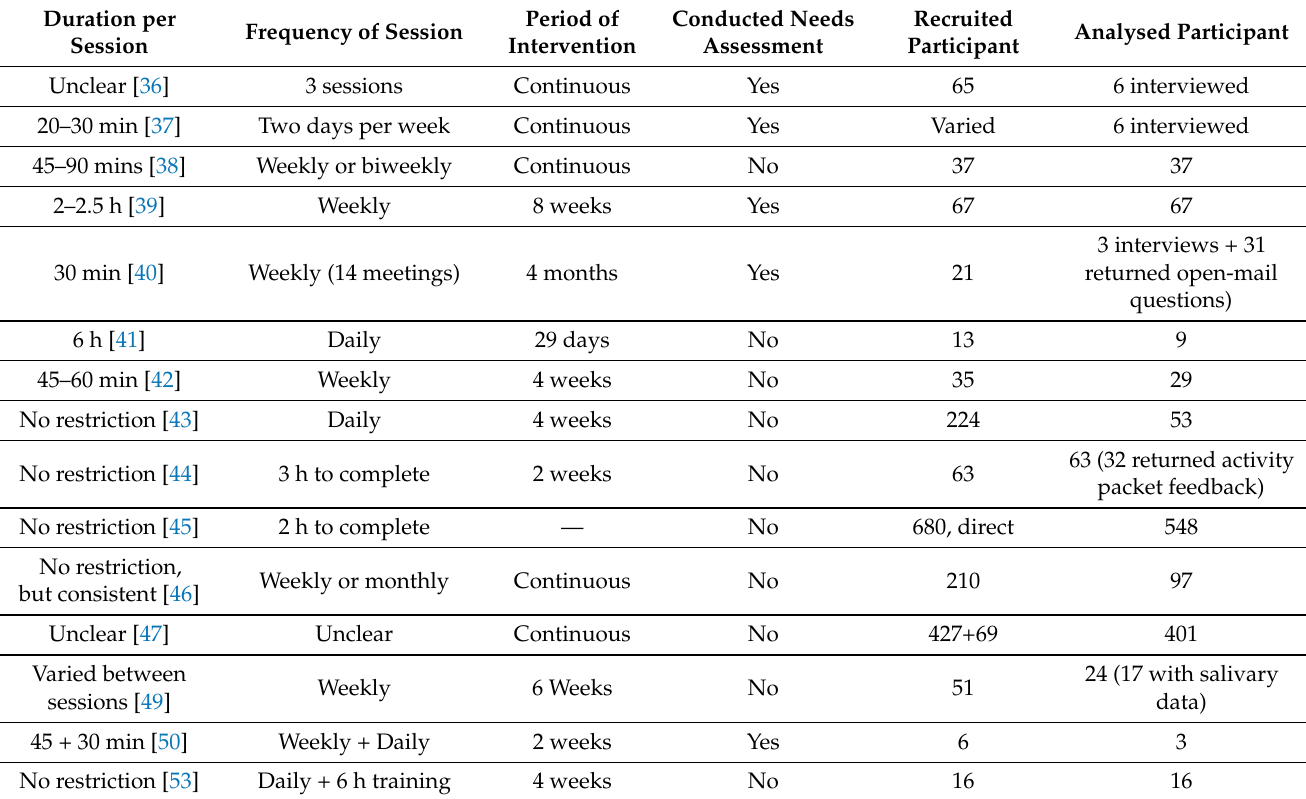
Table 2. Duration and frequency of